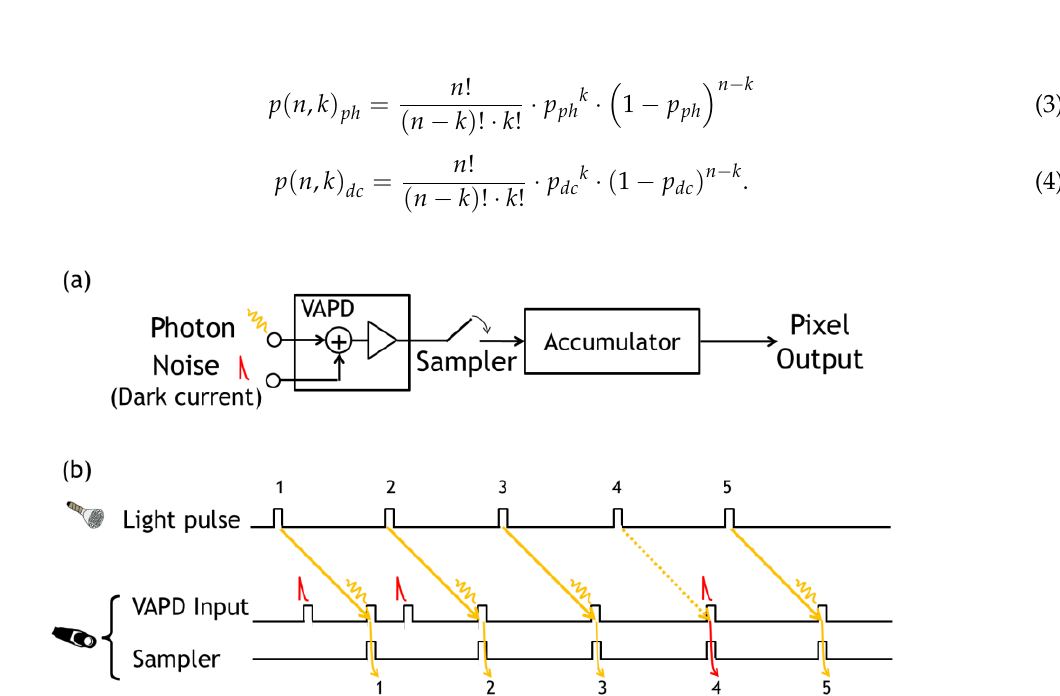
Figure 3. ( a ) A schematic of Photon/Noise pulse detection in VAPD equipped with a pulse sampling and accumulating circuits in the developed Complementary Metal Oxide Semiconductor (CMOS) image sensor (CIS) pixels. ( b ) A schematic timing chart of illuminating light pulse, detection and sampling. Light pulses 1, 2, 3, and 5 are successfully detected and sampled while light pulse 4 is not detected. Instead, at the timing of pulse 4, a noise pulse is sampled. By assuming that each pulse impinging on the sensor contains one or zero photon and using the notations of analysis, the primary parameters used in the analysis from Equation (1) to Equation (4) are calculated as follows. The number of sampling pulses n is 5. The number of detected photon pulses k is 4. The average number of detected photon per sampling, λ ph , is 0.8 and the average number of detecting dark pulse per sampling λ dc is 0.2. The numerical examples of Equations (3) and (4) are calculated and plotted in Figure 4 for n = 20 (a) and for n = 100 (b). It is clearly shown that the photon signal is buried in the dark count pulses when n is 20 (a) but extracted when n is increased to 100 (b).